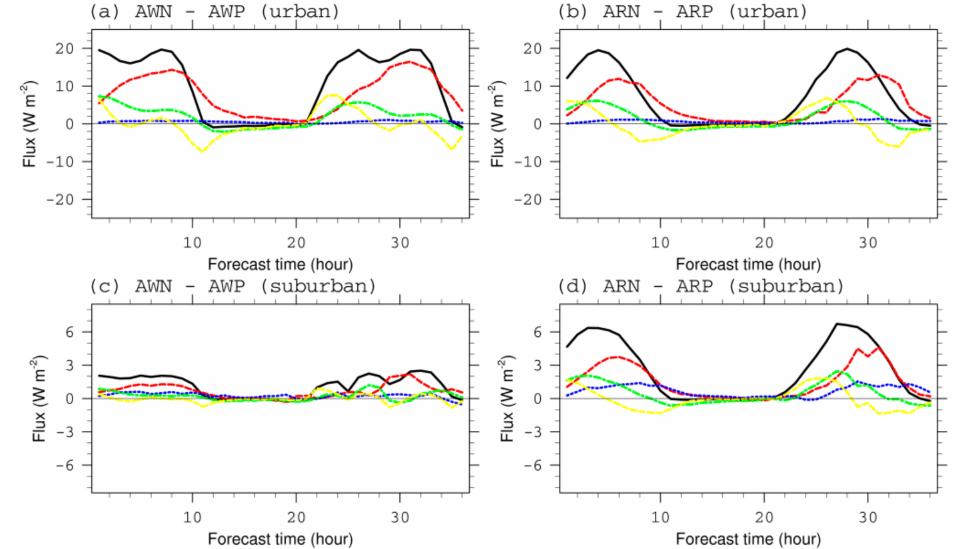
Figure 9. Time series of di ff erences ( a , c ) between AWN and AWP, and ( b , d ) between ARN and ARP of surface energy fluxes averaged at urban points (urban fraction ≥ 0.3, upper) and suburban points (lower). Net radiation flux (black), sensible heat flux (red), latent heat flux (blue), ground heat flux (green), and heat storage flux